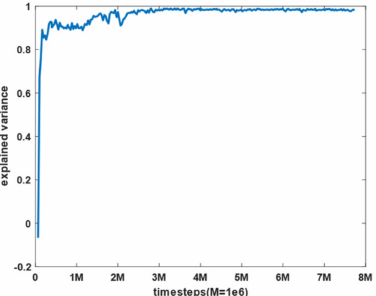
Figure 16. Explained variance of the PPO algorithm in the training